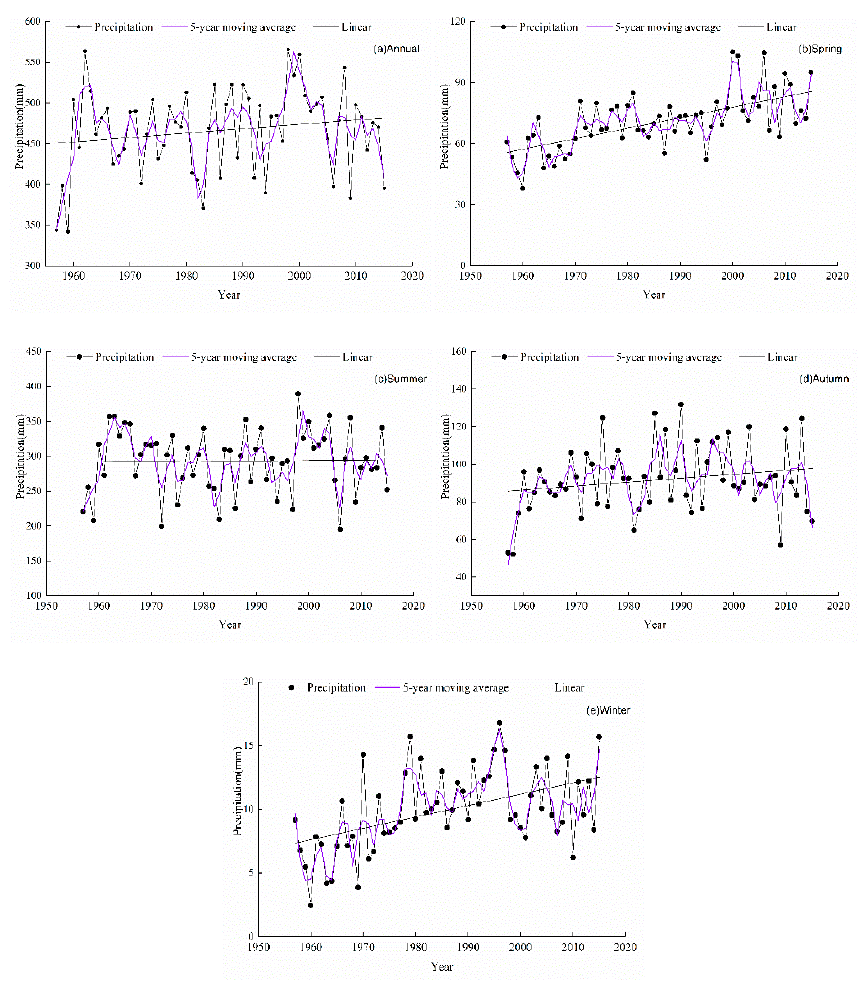
Figure 3. Trends of annual average precipitation and seasonal average precipitation in the YLZR basin from 1957 to 2015.